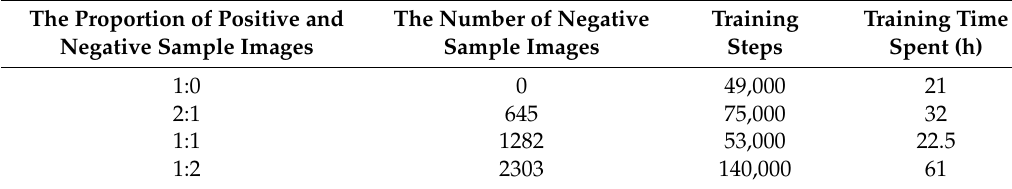
Table 3. Information of networks training with different proportions of positive and negative sample images.